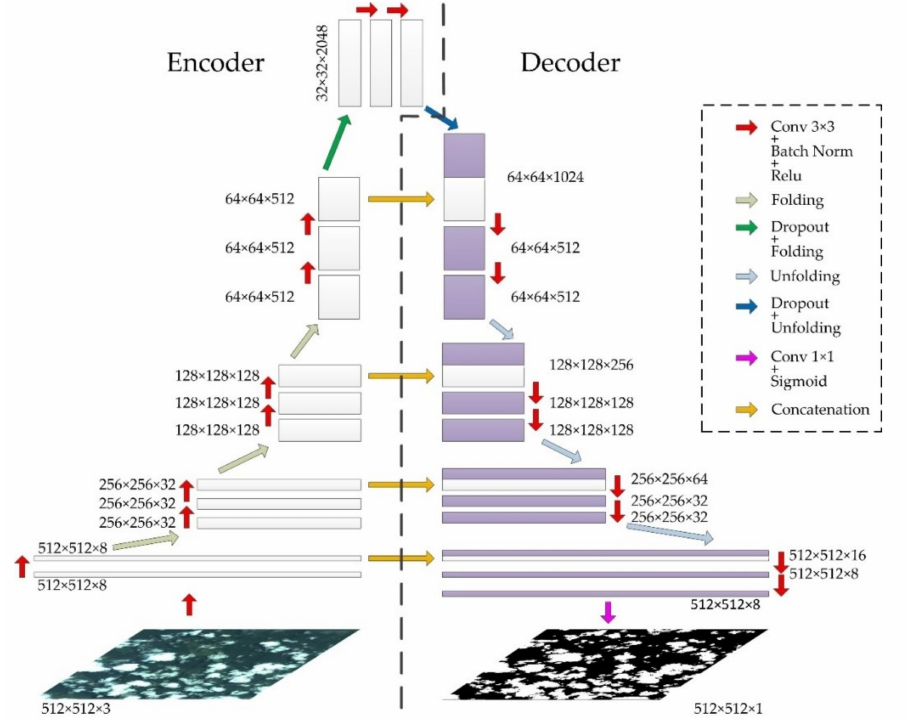
Figure 1. The flowchart of the proposed